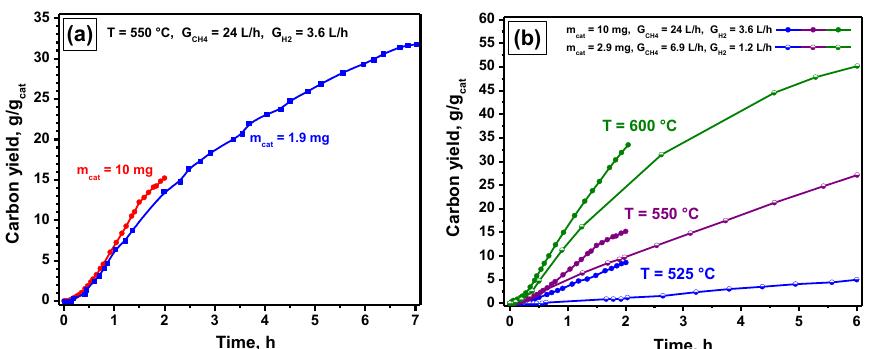
Figure 6. Carbon yield during the decomposition of methane–hydrogen mixture: ( a ) comparison of the catalyst loading; ( b ) comparison of the catalyst loading and the gas flow rates at different tem- peratures.